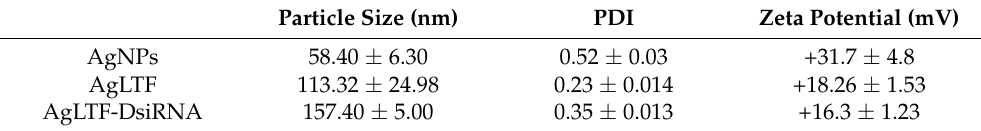
Table 1. The mean particle size, PDI, and zeta potential of AgNPs, AgLTF, and AgLTF-DsiRNA, n = 3.